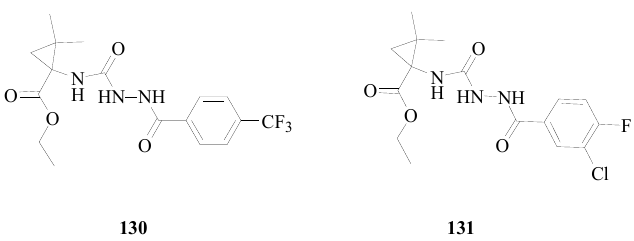
Figure 11. Structures of compounds 130 – 131 .